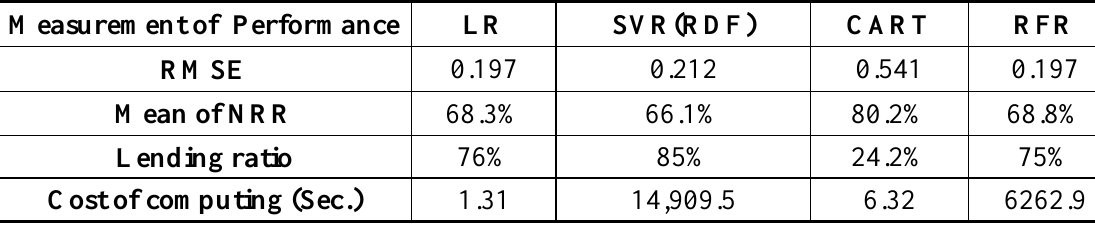
Table 1. Experimental results of four different